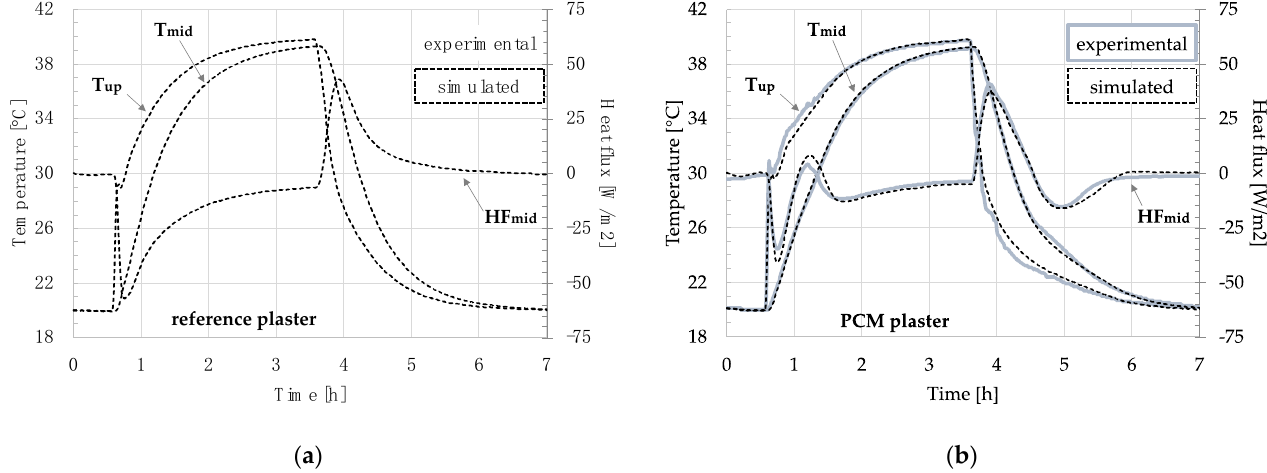
Figure 6. Calibration of the unsteady–state tests. ( a ) Test with the reference plaster, ( b ) test with the PCM plaster.